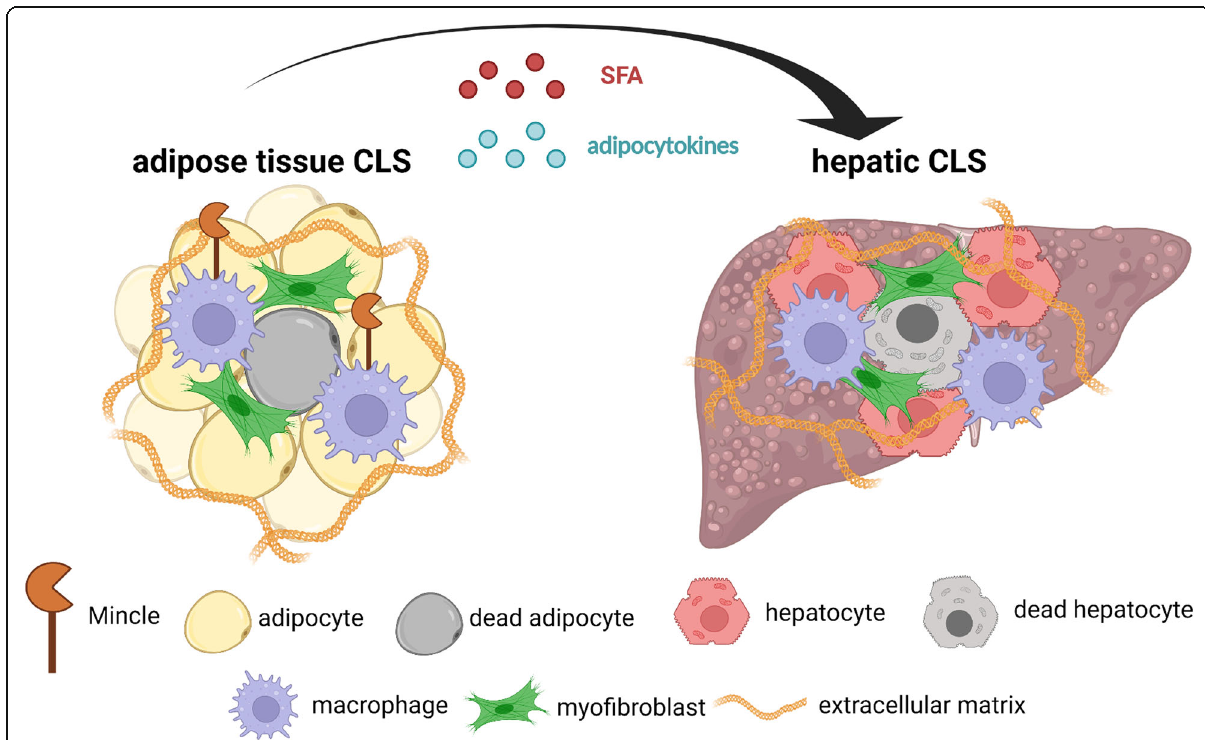
Fig. 2 CLS is a hallmark of obesity-induced chronic inflammation. Obesity induces inflammation and fibrosis in adipose tissue and the liver. Chronic inflammation leads to a characteristic histological structure termed “ crown-like structure (CLS) ” in which macrophages surround dead adipocytes, resulting in fibrosis. An innate immune receptor Mincle functions as a cell death sensor, which is selectively upregulated in the macrophages that constitute CLS in obese adipose tissue. Mincle regulates adipocyte death-triggered fibrogenesis and controls lipid storage function of adipose tissue, thereby affecting ectopic lipid accumulation in remote organs such as the liver. In nonalcoholic steatohepatitis, there is a structure similar to CLS in which macrophages surround dead hepatocytes with excessive lipids. Created with